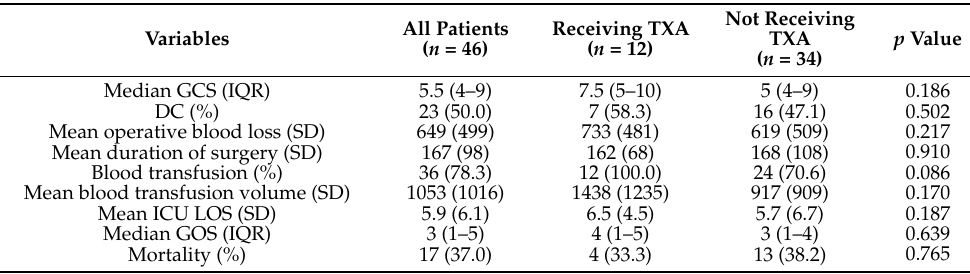
Table 3. Comparison of surgical conditions, blood transfusion, and prognosis of patients receiving and not receiving TXA for